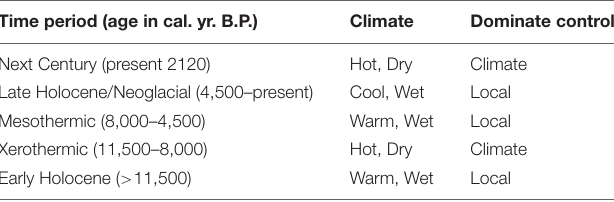
TABLE 2 | Climate history and control on vegetation used in this study of the Southern Interior, BC. Time period (age in cal. yr.